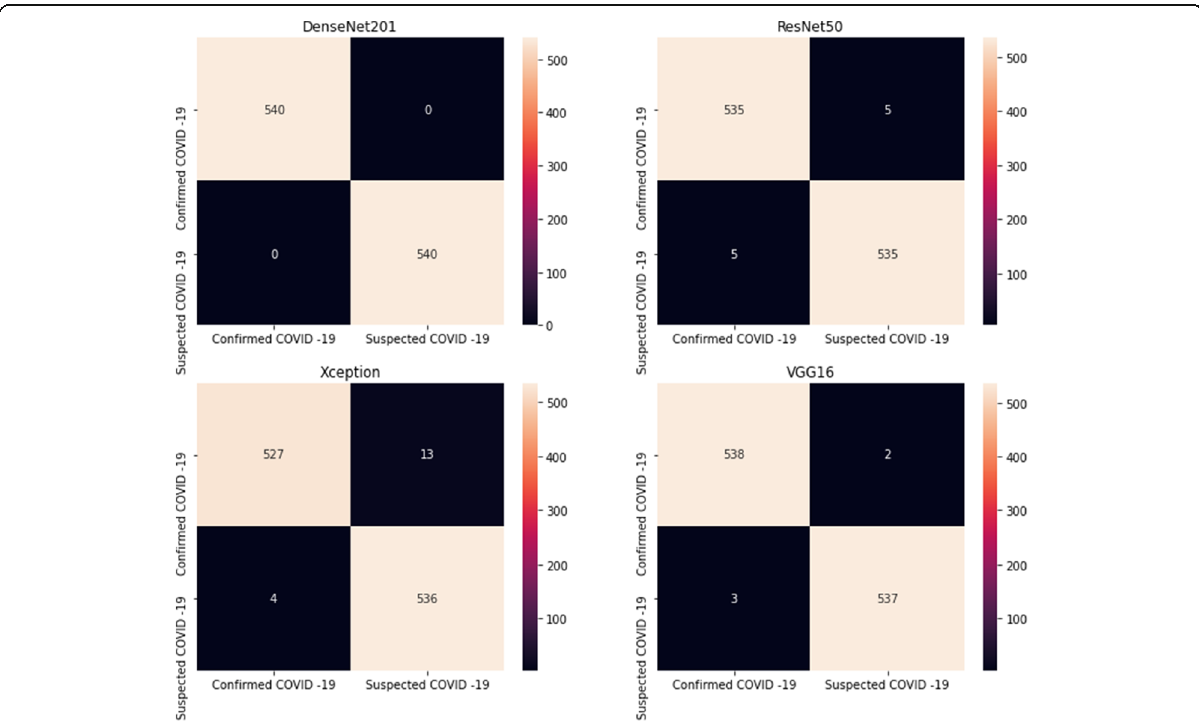
Fig. 5 Confusion matrix analyses and ROC plots of the pre-trained